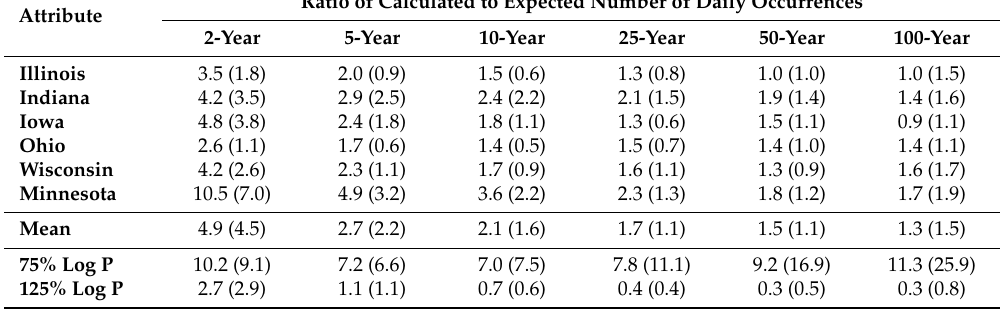
Table 4. The ratio of the calculated to expected number of daily occurrences in a 100-year time period for different recurrence interval